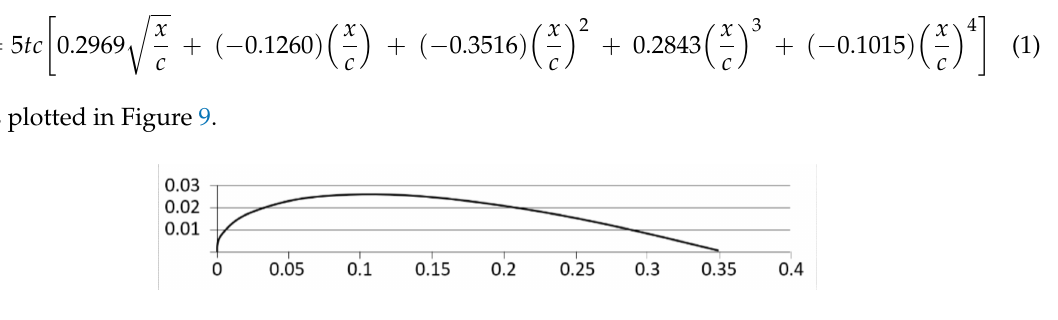
Figure 9. Selected wing